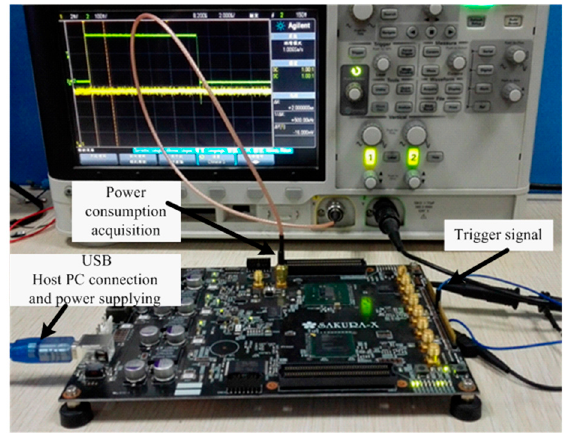
Figure 2. Photo of differential power analysis (DPA) attack platform.